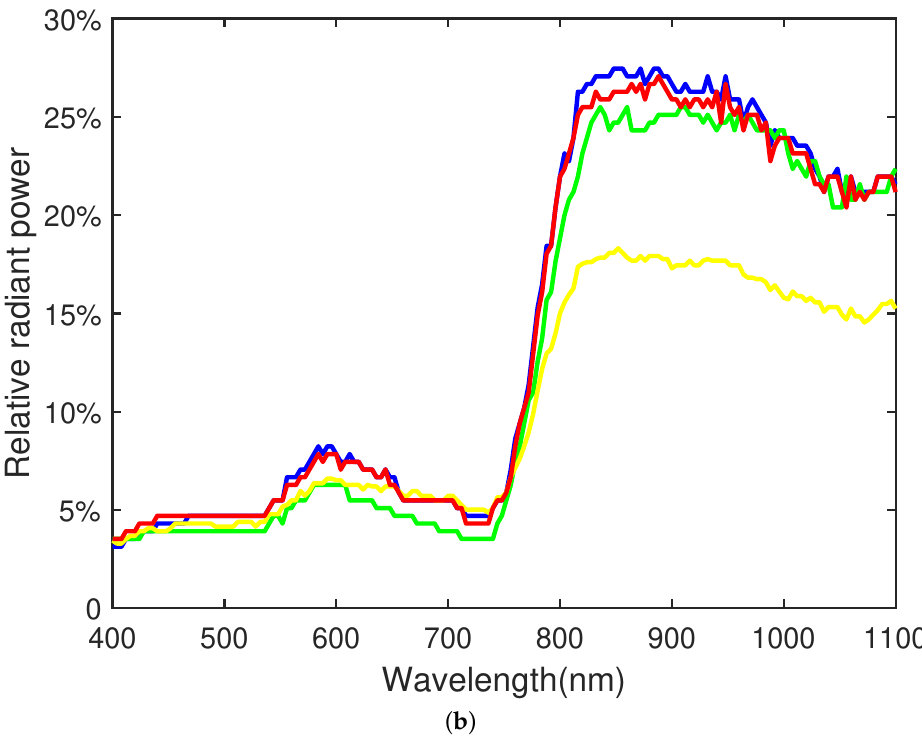
Figure 12. Spectral analysis. Blue and green curves are the spectrum of the two original images before stitching. Blue, spectrum of the reference image; yellow, the spectrum without spectral correction; red, the spectrum after spectral correction. ( a ) sift; ( b )